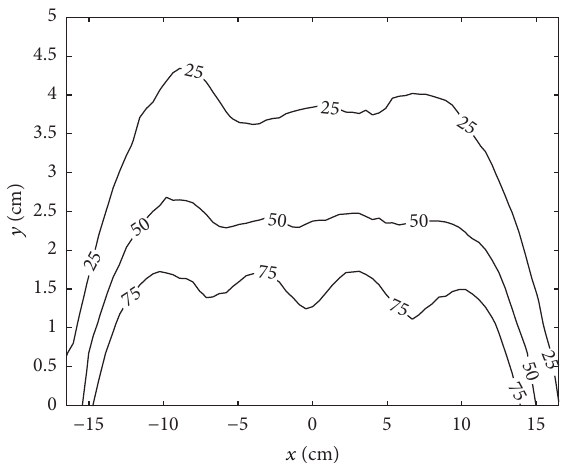
Figure 12: Contours of SAR distribution in the plane perpendicular to the applicator aperture. The plane cuts the inductive posts in the middle. SAR values are given as percentages of the highest value in the considered plane at the depth of